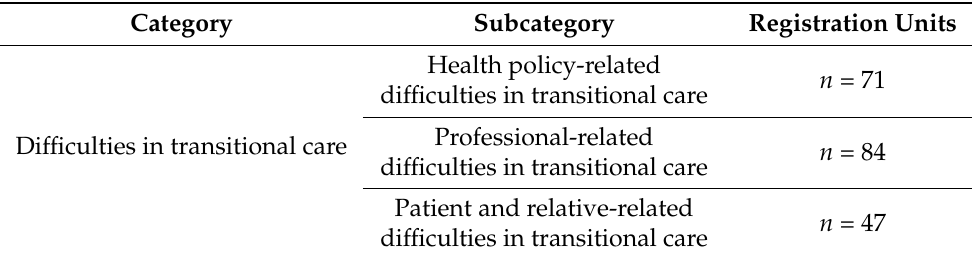
Table 2. Difficulties in transitional care; Portugal. 1 October 2018 to 31 August